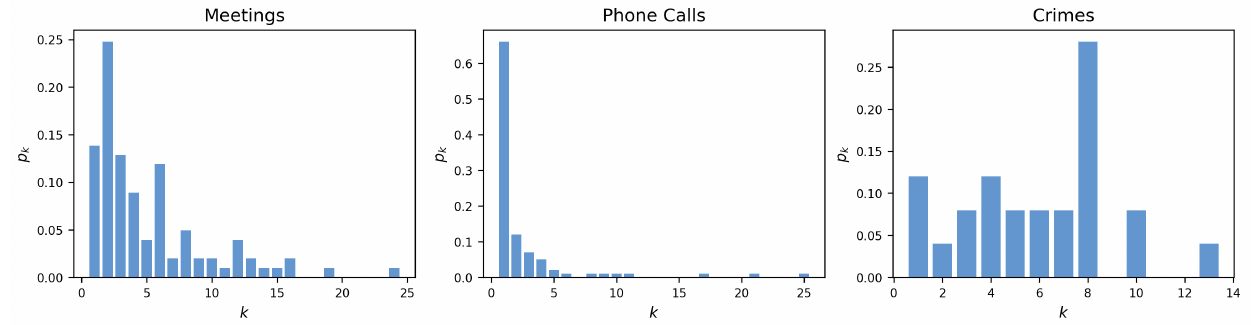
Figure 4. Degree distributions of the three layers—Meetings, Phone Calls and Crimes—where p k provides the probability that a randomly selected node in each layer has degree k .